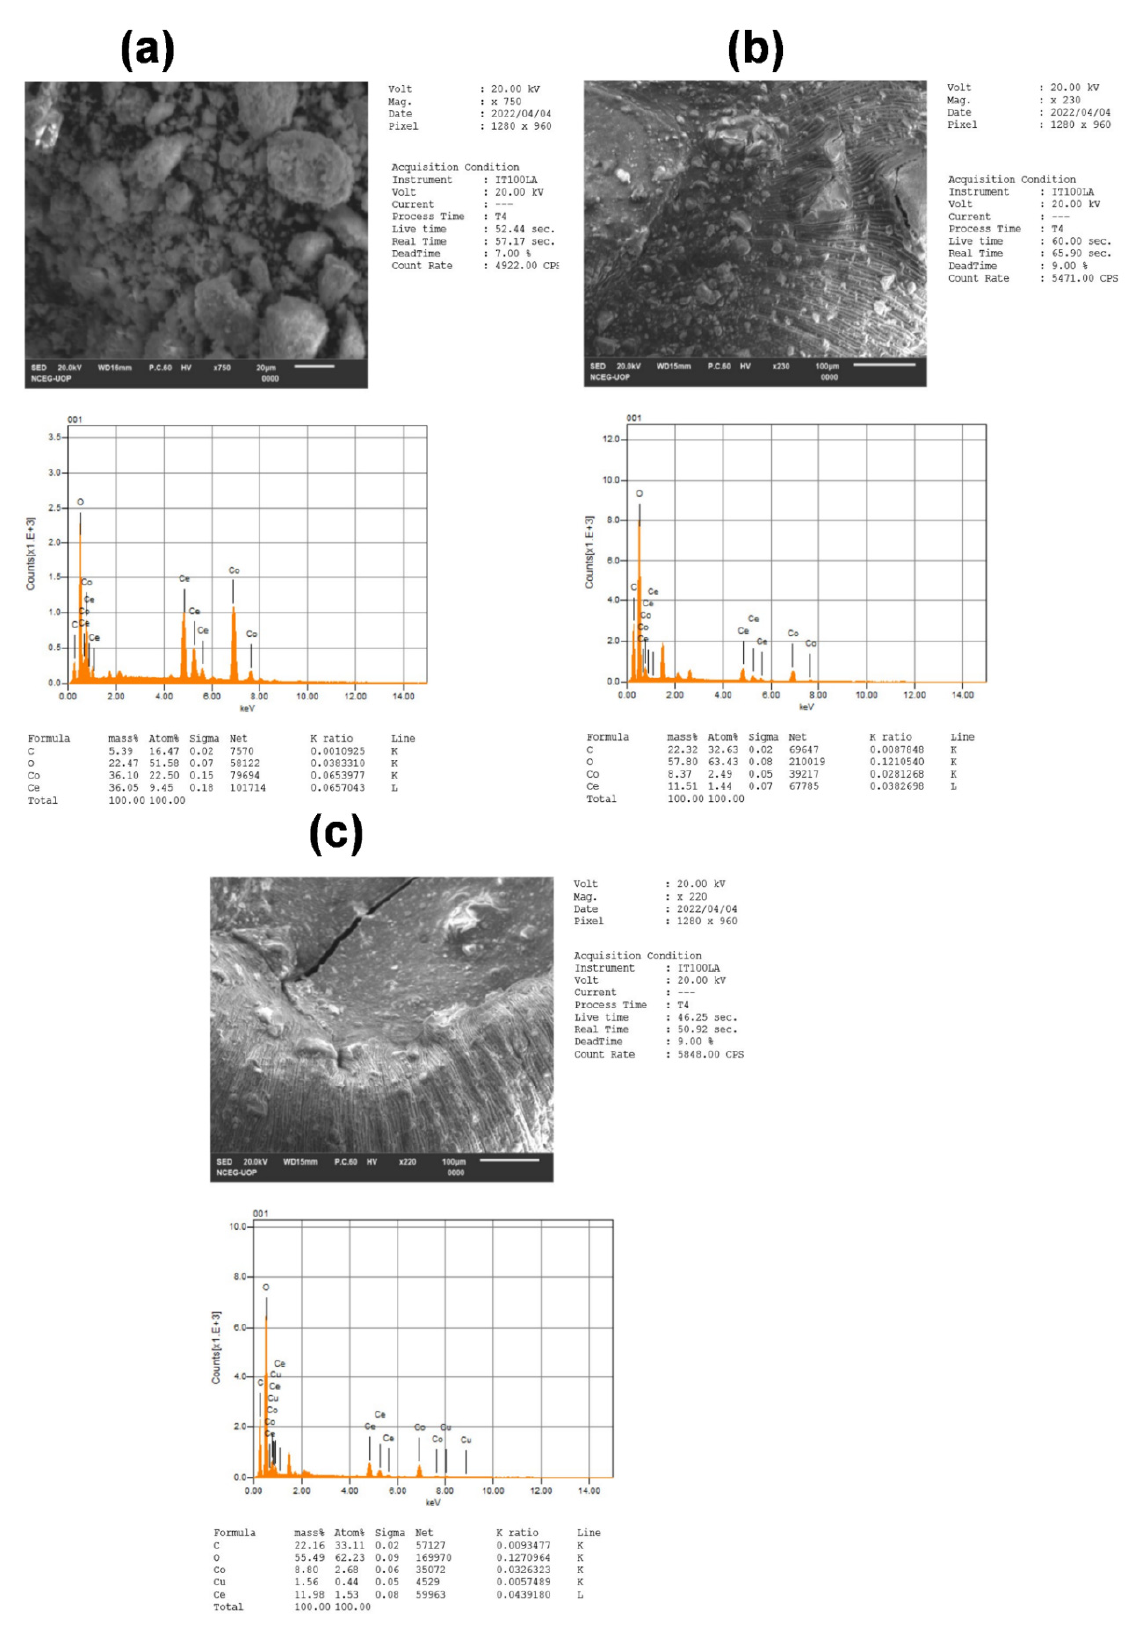
Figure 2. EDS spectra of ( a ) Co–CeO 2 , ( b ) Alg/Co–CeO 2 , and ( c ) Cu@Alg/Co–CeO 2 .